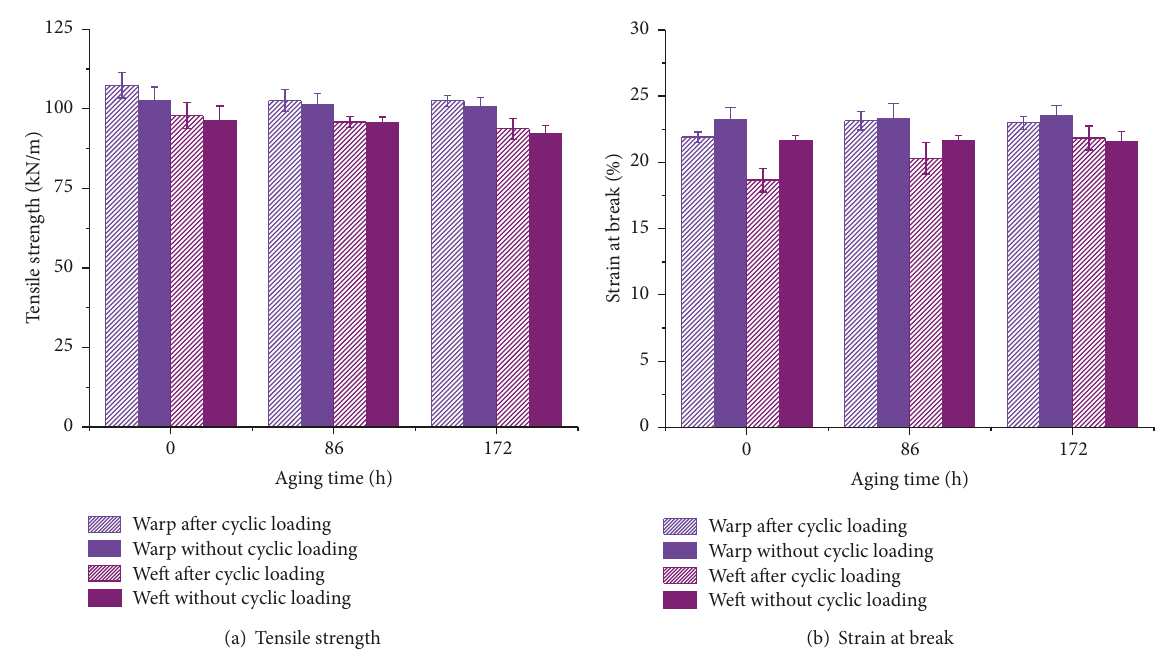
Figure 8: Tensile properties of materials (after cyclic loading) after